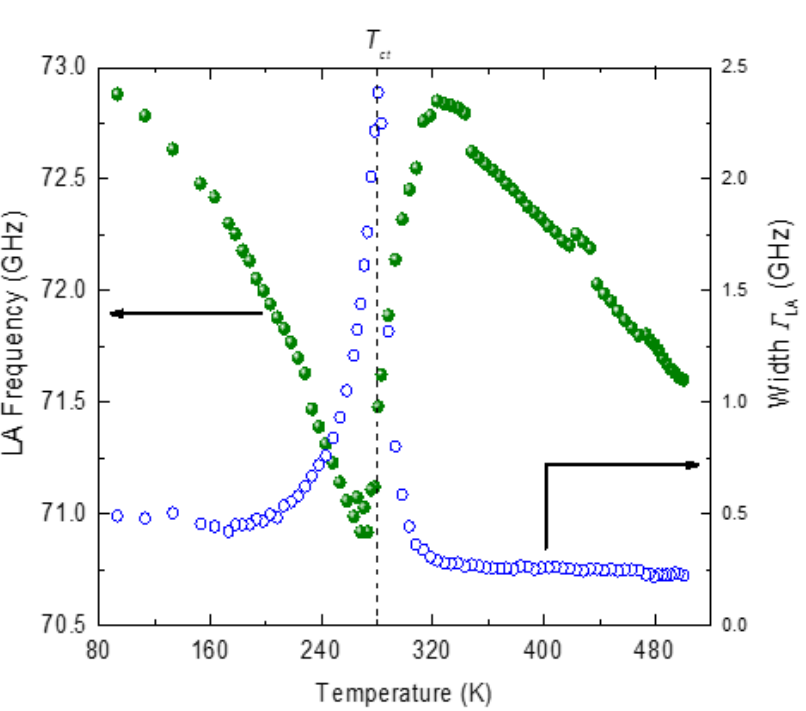
Figure 17. Temperature variation inthe frequency and the width of the SCT-0.03LA phonon. (Reprinted with kind permission from Ref. [83]. Copyright (2020) The Japan Society of Applied Physics).